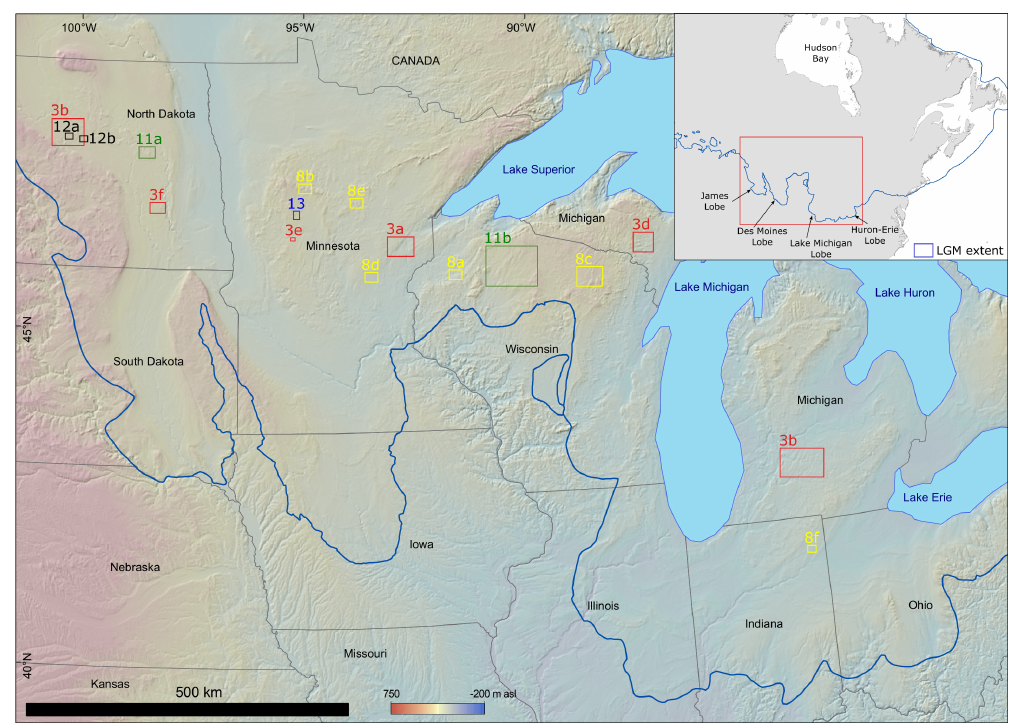
Figure 2. Location map showing the Last Glacial Maximum (LGM) extent (blue line) and major ice lobes and topography. Boxes refer to detailed examples shown in Figs. 3 (red), 8 (yellow), 11 (green), 12 (black) and 13